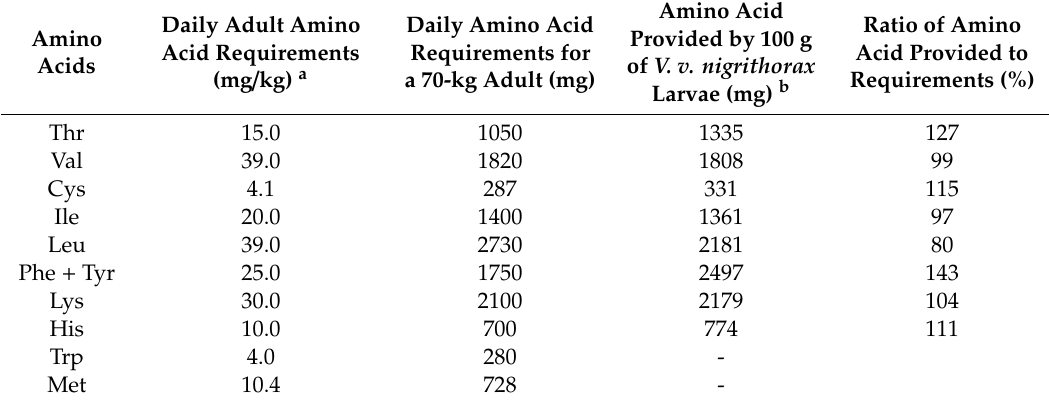
Table 6. Comparison of the essential amino acids amounts required for an adult per day and amino acids contained in 100 g of V. v. nigrithorax